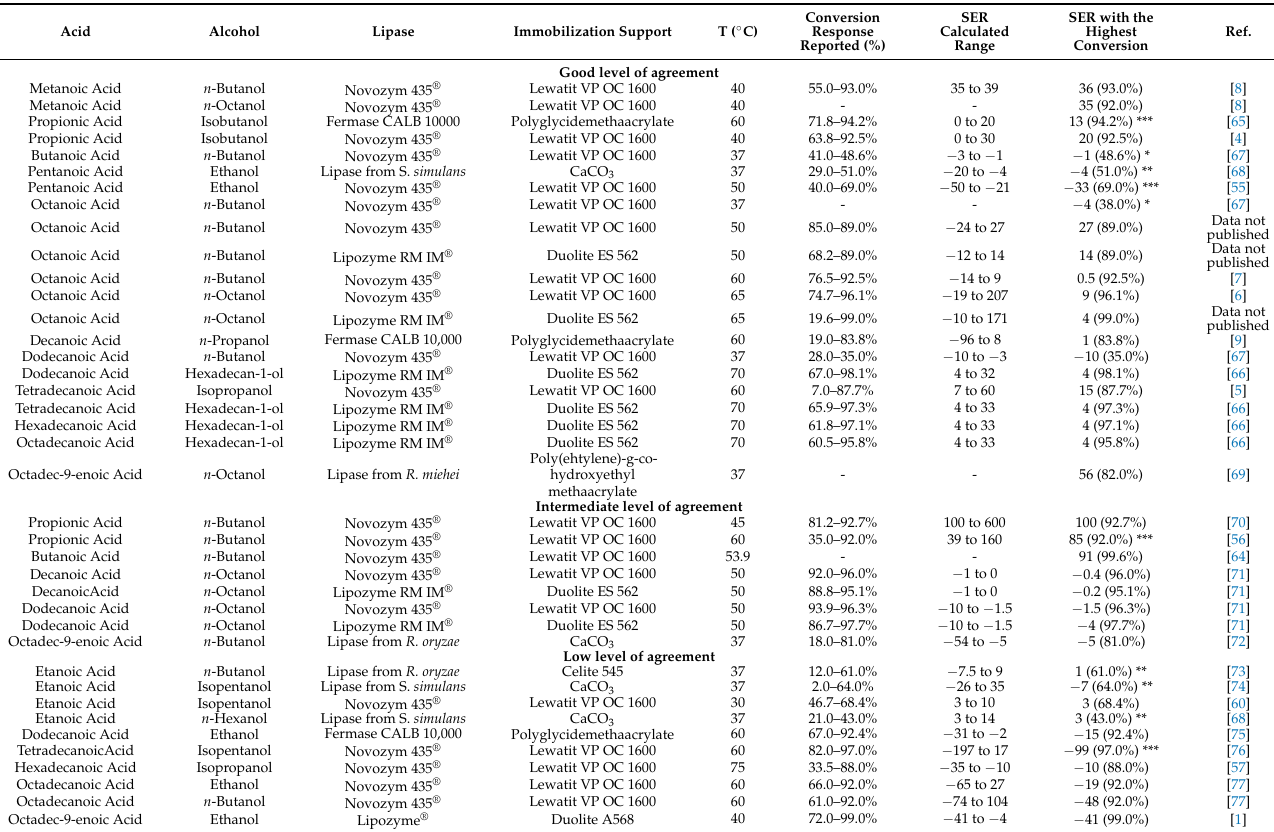
Table 1. Enzymatic syntheses studies of aliphatic esters in solvent-free systems with calculated SER and its respective conversion